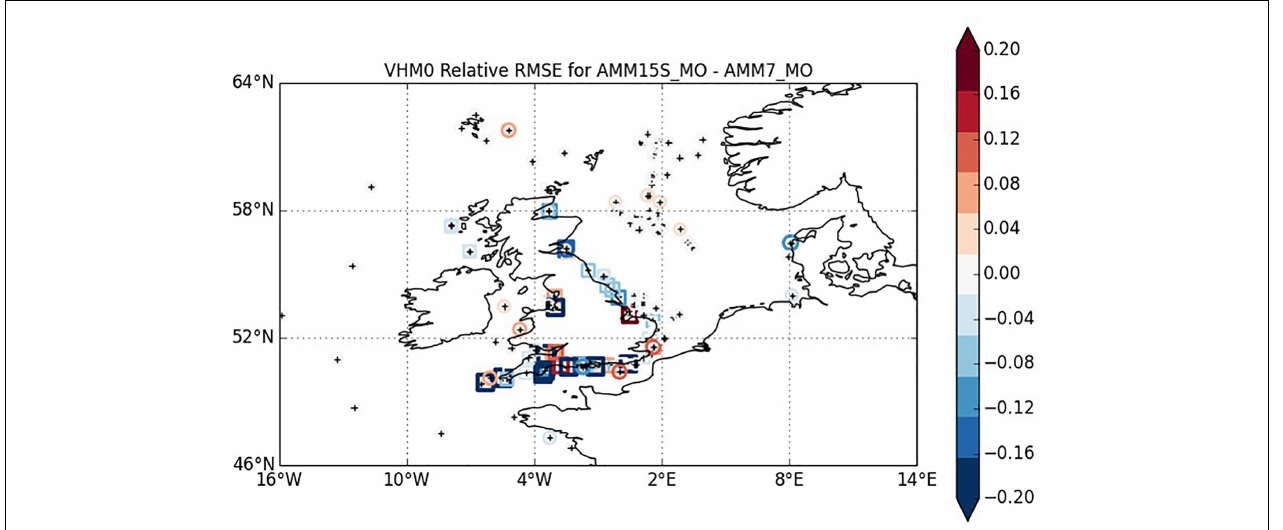
FIGURE 8 | Relative change in normalized root-mean-square error (RMSE) of significant wave height (denoted VHM0 following CMEMS variable naming convention) compared with in-situ observations for 3–1.5 km versus 7 km WAVEWATCH III models (AMM15 and AMM7, respectively). The error shows a degradation in performance in red and an improvement in performance in blue, where AMM15 NRMSE changes relative to AMM7 NRMSE. The increasing resolution has a largely neutral impact in open waters, while for coastal zone predictions a majority of in-situ sites verify better for the AMM15